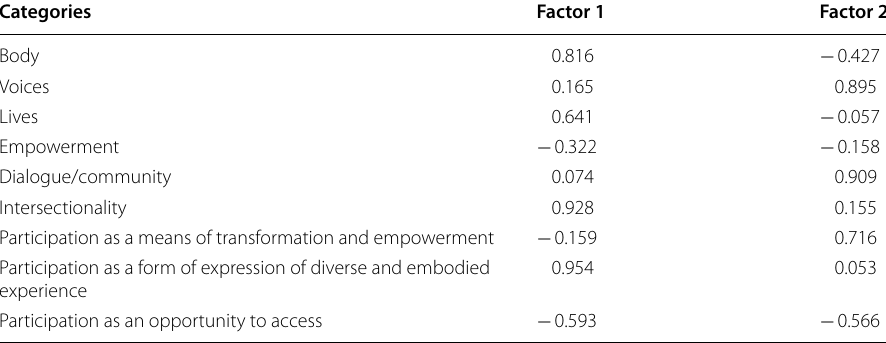
Table 4 Matrix of rotated